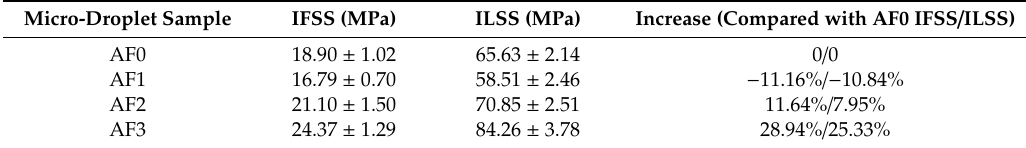
The interfacial shear strength (IFSS) / interlaminar shear strength (ILSS) value of di ff erent specimen.